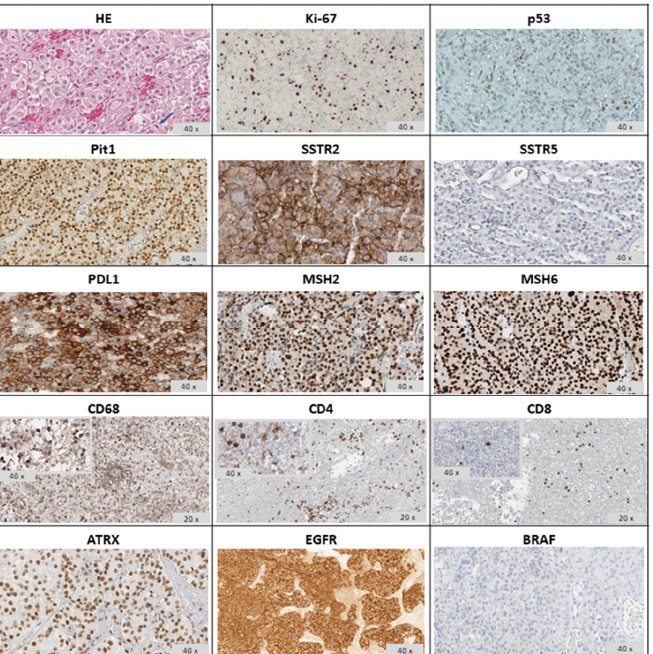
Figure 2. Pathological characteristics of the tumor at last surgery: Shown are mitosis on hematoxylin-eosin ( HE ) staining (indicated by an arrow); immunostaining for Ki67 (20%) with positive p53 staining (10%); diffuse nuclear Pit1 immunoreactivity; positive SSTR2 immunoreactivity and negative SSTR5 expression; diffuse PDL1 expression in neoplastic cells (95%), diffuse nuclear MSH2 and MSH6 expression; tumor-infiltrating inflammatory cells consisting of a predominance of macrophages ( CD68 +), with CD4 + lymphocytes exceeding in number CD8 + lymphocytes. Other molecular markers include ATRX , revealing a diffuse nuclear immunoreactivity; diffuse EGFR staining with some membranous enhancement, and negative BRAF V600E staining. In addition (data not shown), immunostaining for pituitary hormones was negative as already observed at first surgery, the tumor presented an unmethylated pattern of the MGMT promoter and, as previously reported, no telomerase abnormalities [24].